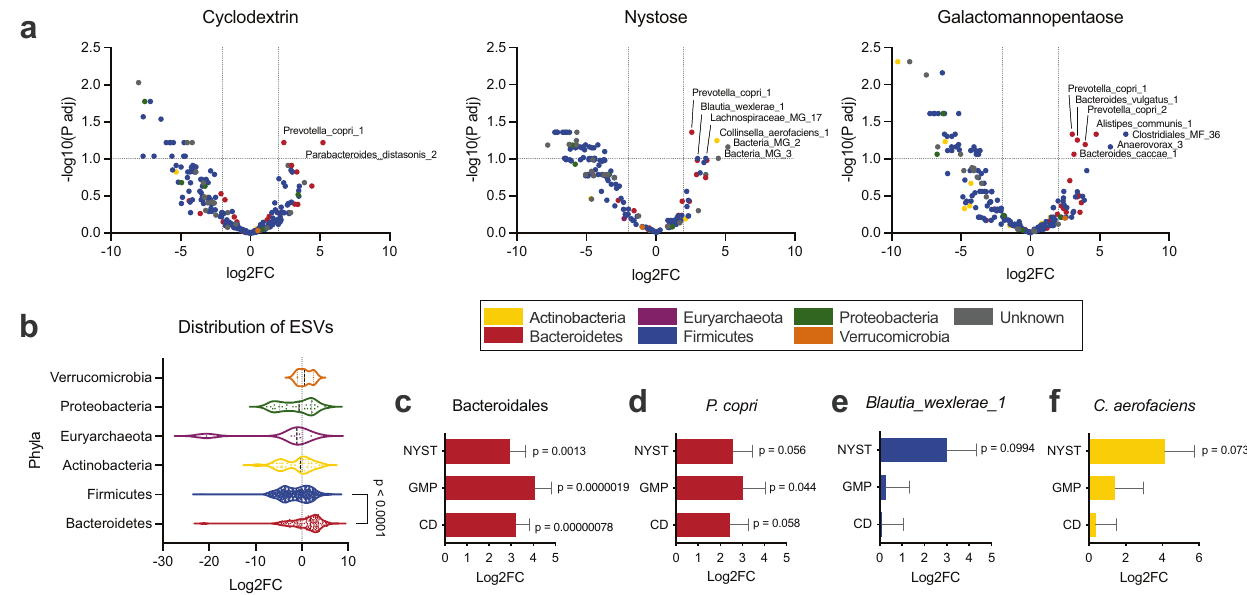
Fig.3|Metaboliclabelingenrichesdifferentbacteriadependingontheglycans applied. a DESeq2 differential abundance analysis comparing the ESV abundance in the starting stool versus the glycan + samples expressed as a volcano plot of the adjusted p value as a function of the log2-fold change. The horizontal line repre- sentsstatisticalsigni fi canceandisdrawnatanFDR of0.1.Thesymbolsarecolored according to the phyla, and the ESVs that are statistically overrepresented in the glycan + samples are labeled. b Distribution of the ESVs from the main phyla on the